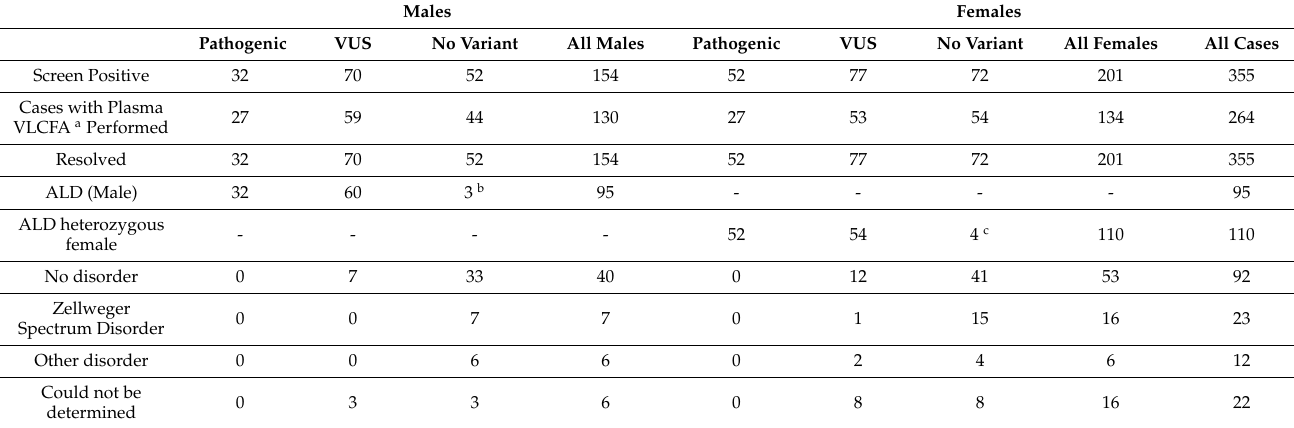
Table 1. Short term follow-up outcomes for screen positives by sex and ABCD1 variant